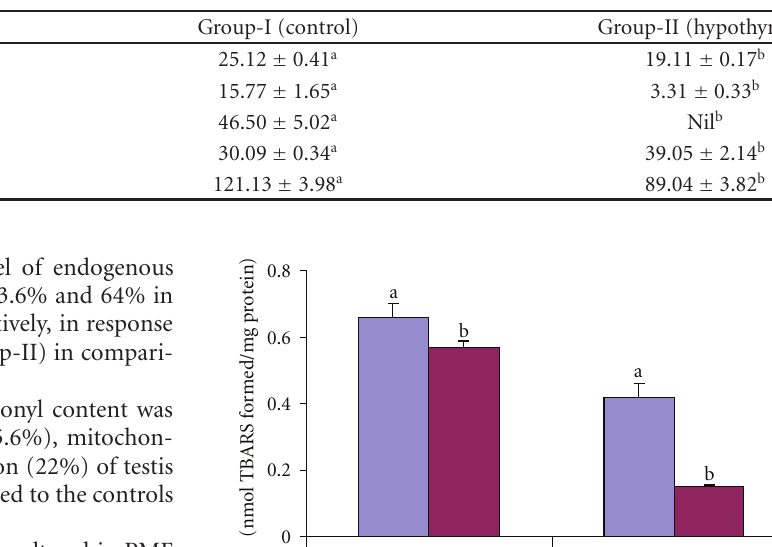
Table 4: E ff ect of neonatal PTU treatment on germ cell count (number/tubule) and seminiferous tubule diameter (expressed in µ ) in Stage- VII seminiferous tubules of testes. Data are expressed as mean ± S.D. of 5 observations from five di ff erent animals and subjected to unpaired Student’s t -test. Each observation per animal is the mean of 30 observations. Statistical significance was accepted at P < 0 . 05. Control and hypothyroid groups were found to di ff er significantly at P < 0 . 05 as represented by superscripts of di ff erent letters. Group-I (control): 30-day-old control rats; Group-II (hypothyroid): 30-day-old rats with PTU treatment from day 1 postpartum to day 30 postpartum.